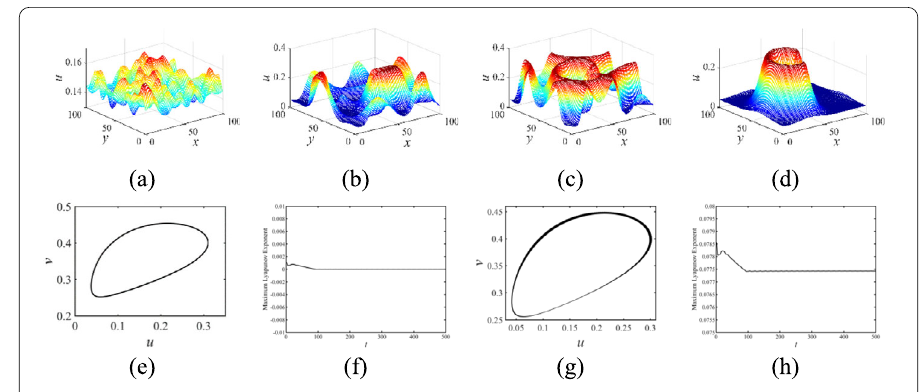
Figure 7 Self-organziation and nonlinear properties of a circle pattern. ( a )–( d ) Evolution of the prey pattern at transient times t = 100, t = 1000, t = 3000, and t = 5000, respectively; ( e )–( h ) phase portraits and maximum Lyapunov exponent diagrams in the cases of uncoupling and coupling the population diffusion. The parameter values are given as a = 1.1, e 1 = 0.3, e 2 = 0.2, b = 0.2, τ = 1.89, δ = 2, h = 10, n = 100